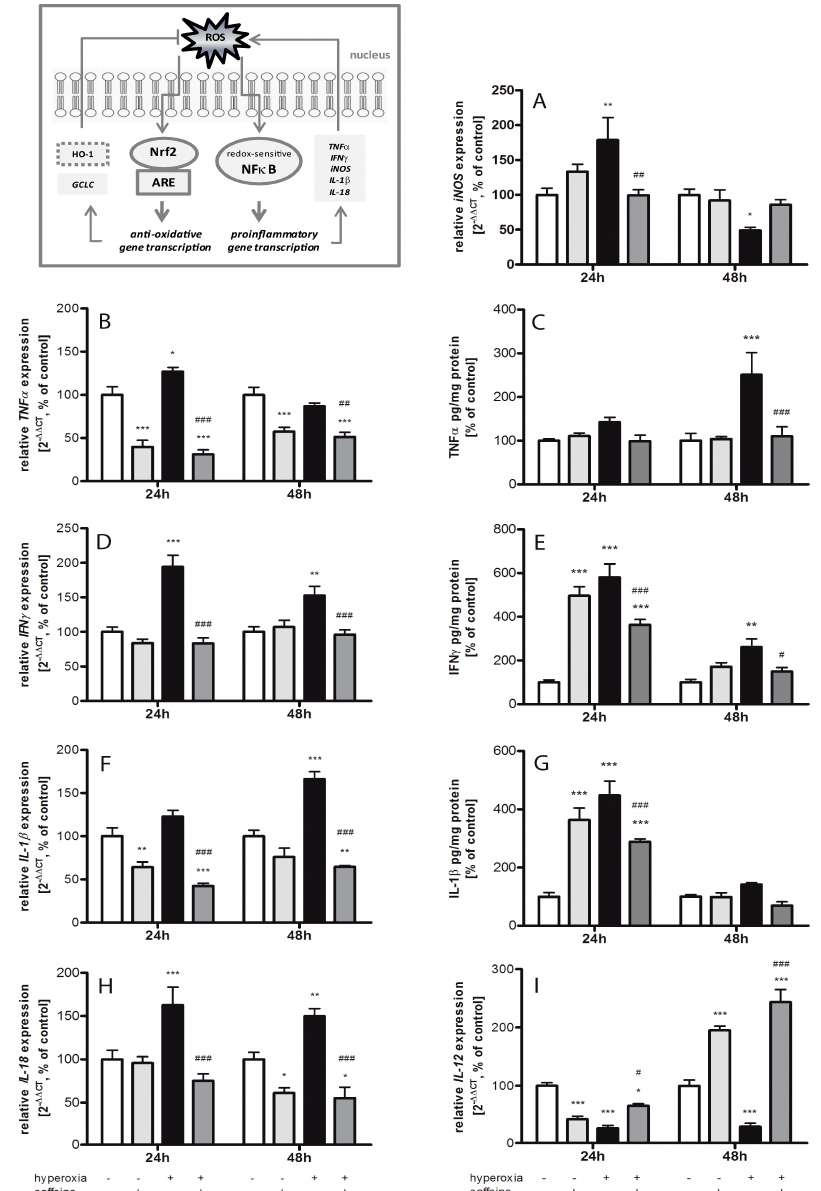
Figure 3. Changes in the expression of cytokines and iNOS in neonatal rat brains after hyperoxic injury with and without caffeine. ( Box ) Nrf2 activation promotes the expression of anti-oxidative gene transcription and reduces oxidative stress-induced inflammatory activation by blocking the redox-sensitive NF κ B pathway (ARE; antioxidant response element). The protein concentration (pg/mg protein) and relative mRNA expression of cytokines were measured in brain homogenates from normoxia ( white bars ), caffeine with normoxia ( light grey bars ), hyperoxia ( black bars ), and hyperoxia with caffeine (dark grey bars) by ELISA assay and quantitative real-time PCR of: ( A ) iNOS ; ( B , C ) TNF α ; ( D , E ) IFN γ ; ( F , G ) IL-1 β ; ( H ) IL-18 ; and ( I ) IL-12 . Data are shown as mean ± SEM, n = 4–5 per group per time point. The 100% value is: ( A ) 1.016 and 1.015 C T ; ( B ) 1.021 and 1.018 C T ; ( C ) 21.22 and 29.19 pg/mg protein; ( D ) 1.012 and 1.013 C T ; ( E ) 1.701 and 2.121 pg/mg protein; ( F ) 1.021 and 1.010 C T ; ( G ) 16.58 and 8.37 pg/mg protein; ( H ) 1.026 and 1.016 C T ; and ( I ) 1.006 and 1.019 C T for 24 and 48 h groups, respectively. Data were analyzed by two-way ANOVA with Bonferroni post hoc test, with * p < 0.05, ** p < 0.01, and *** p < 0.001 versus control (atmospheric air), and # p < 0.05, ## p < 0.01, and ### p < 0.001 versus hyperoxia (80% oxygen without caffeine).